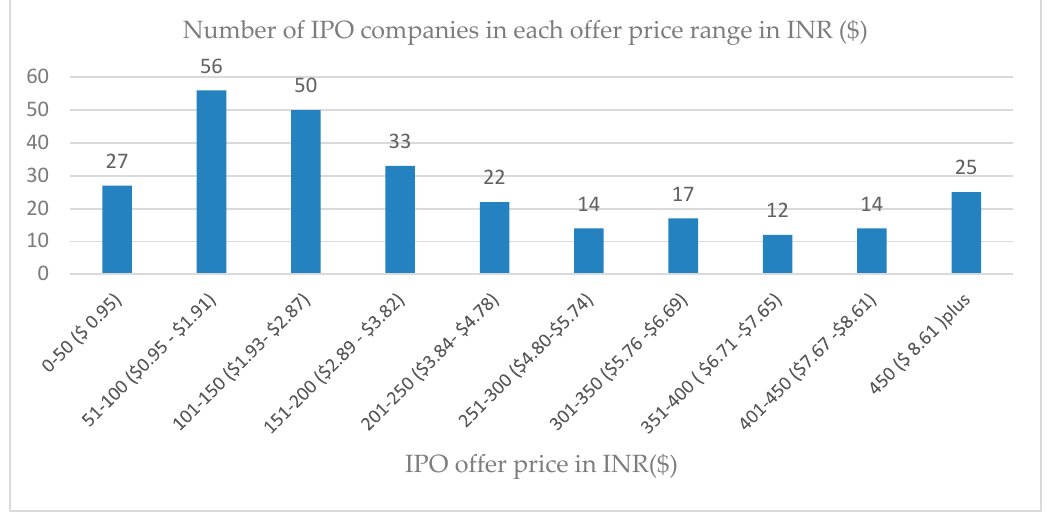
Figure 1. Initial public offer (IPO) offer price bands across companies in Indian National Rupees (INR) (2006 – 2015). The INR conversion to UDS $ is done at an average rate between 2006–2015. Source— Prime database, NSE India, and Source-RBI forex.